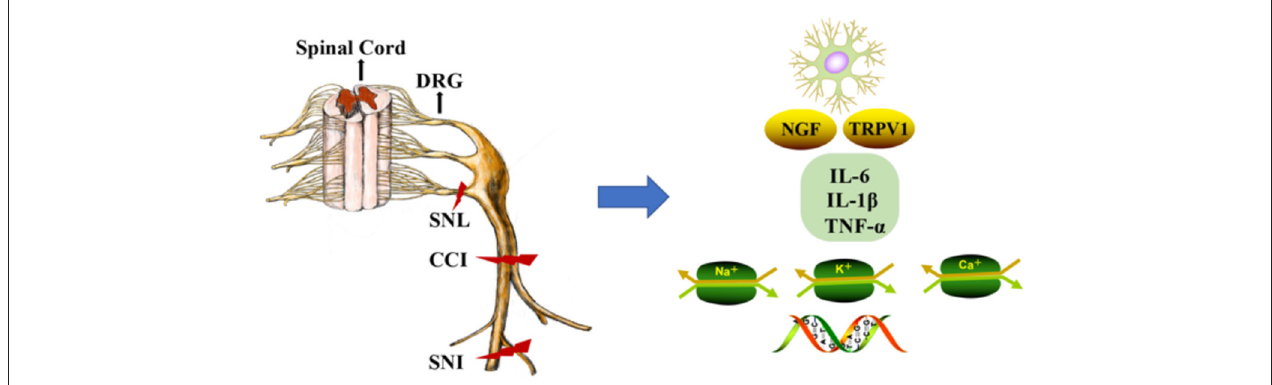
FIGURE 1 | DNA methylation in the mechanism of neuropathic pain (NP). The dorsal root ganglion (DRG) and spinal cord produce glial cell responses, stimulating inflammatory cytokines, nerve growth factors, gene expression, and ion channels under the environment of peripheral afferent fiber injury. CCI, chronic constriction injury; SNL, spinal nerve ligation; SNI, spared nerve injury; DRG, dorsal root ganglion; NGF, nerve growth factors; Na + , Na + channels; K + , K + channels; Ca + , Ca +